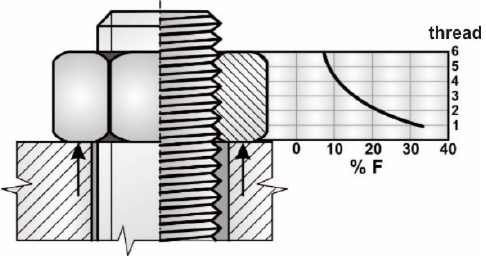
Figure 4. The uneven force F distribution in the threads.